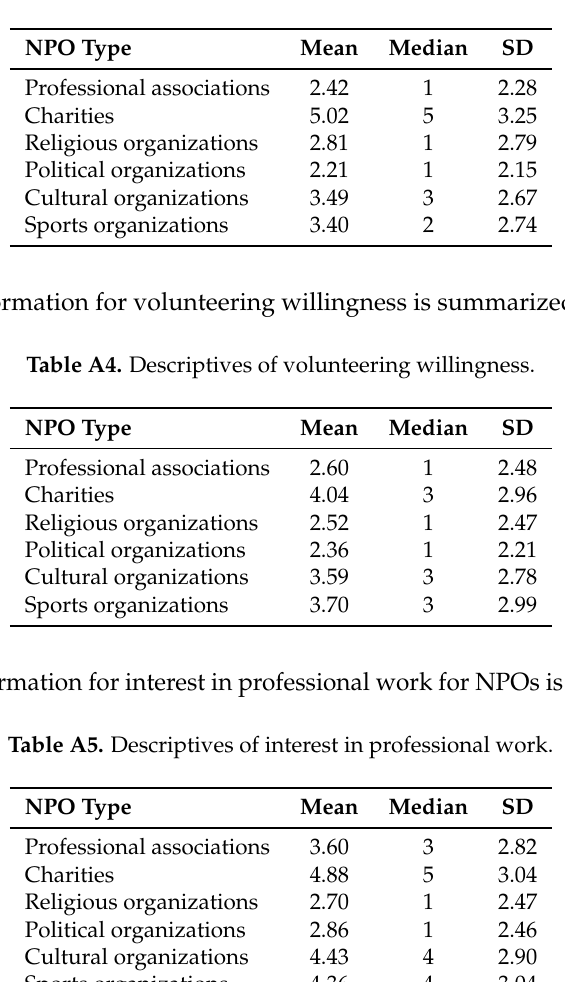
Table A3. Descriptives of donation willingness.